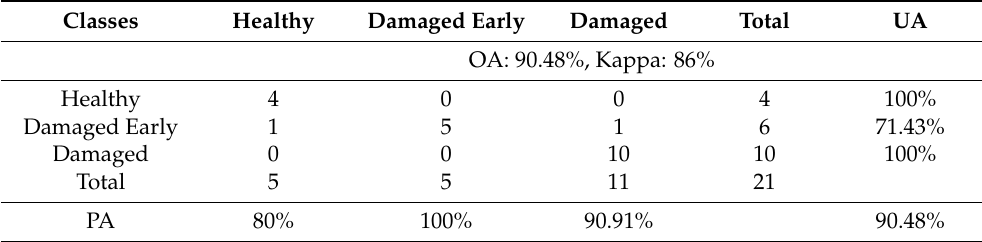
Table 5. Confusion matrix and evaluation index based on optimal mother wavelet basis (bior4.4) model of dry weight moisture